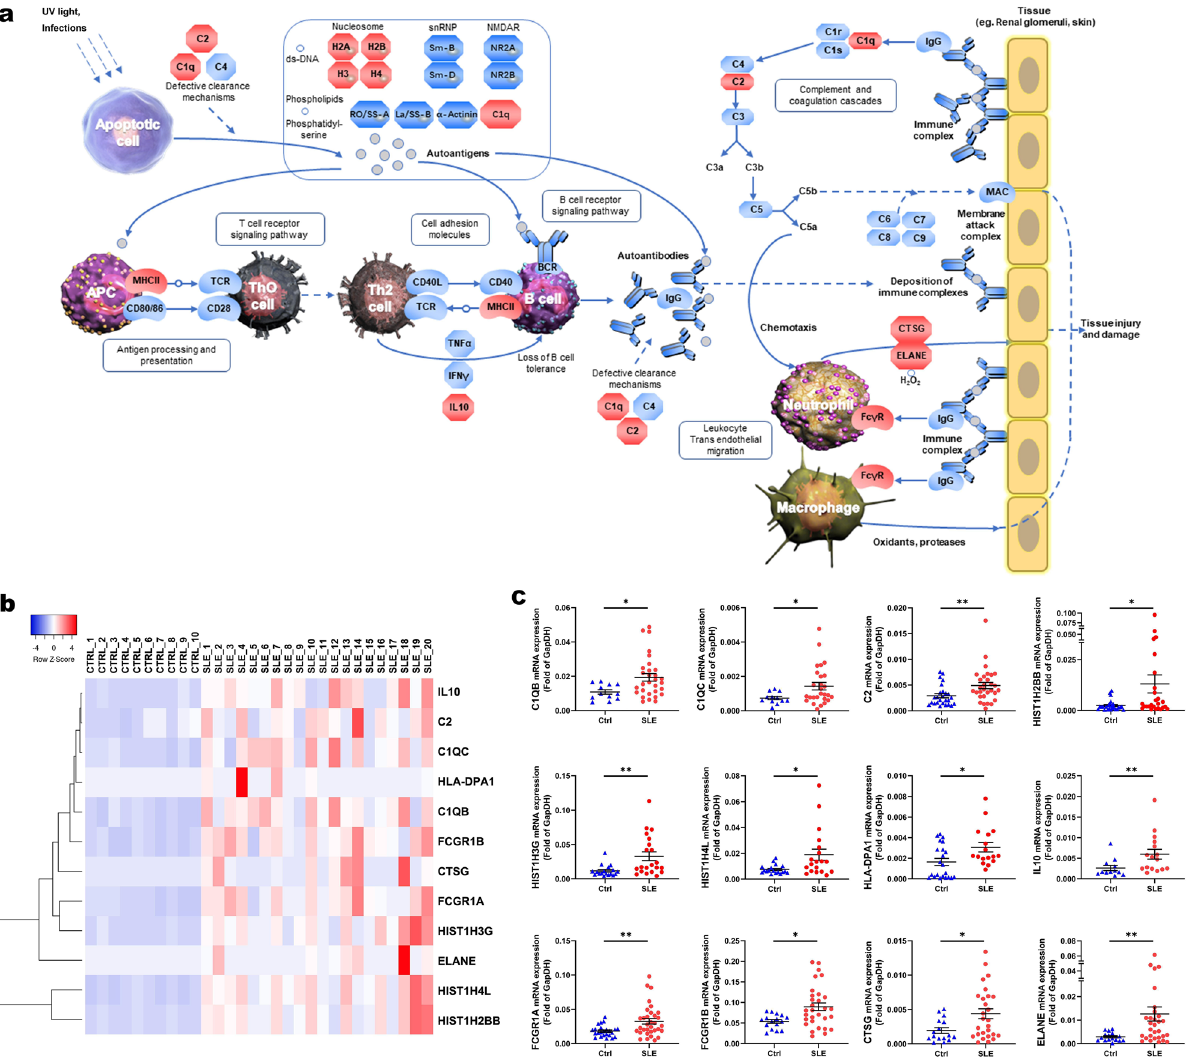
Figure 4. Upregulated genes mapped to systemic lupus erythematosus pathway. (a) Model diagram of systemic lupus erythematosus pathway, genes marked in red are significantly upregulated genes. (b) Cluster analysis was performed on 12 genes with significant differences between the systemic lupus erythematosus (SLE) group and the control (CTRL) group. (c) Quantitative real-time PCR (qRT-PCR) validation of the upregulated genes mapped to the SLE pathway. *** P < 0.001, ** P < 0.01, * P <